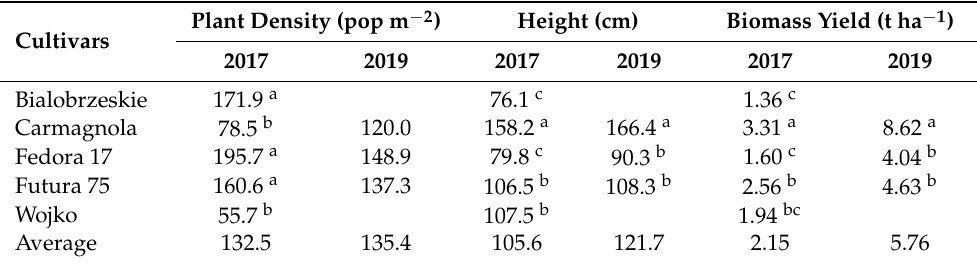
Values within a column with the same letter are not significantly different at p ≤ 0.05.